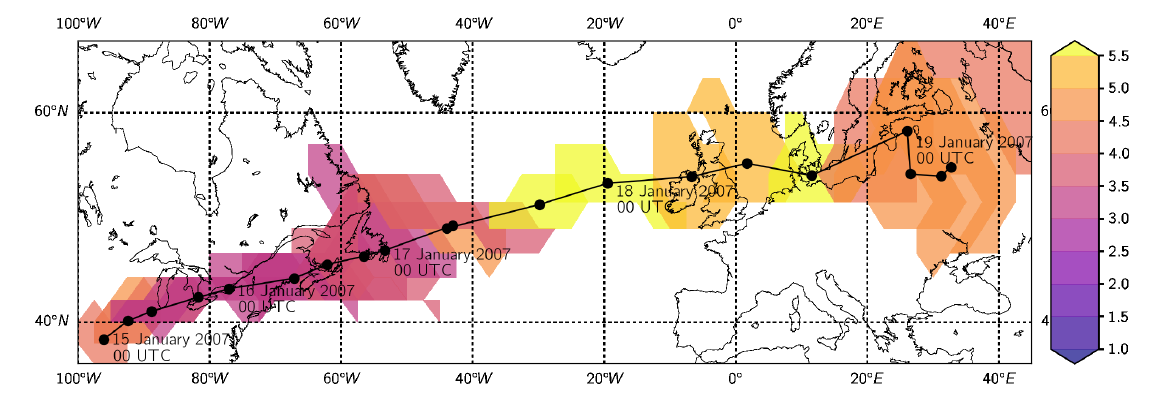
Figure 2. Area of Kyrill derived from NCEP data color shaded by its mean vorticity (in 10 − 5 s − 1 ) at 850hPa followed over its lifetime. Black dots indicate the circulation center of Kyrill at six-hourly time